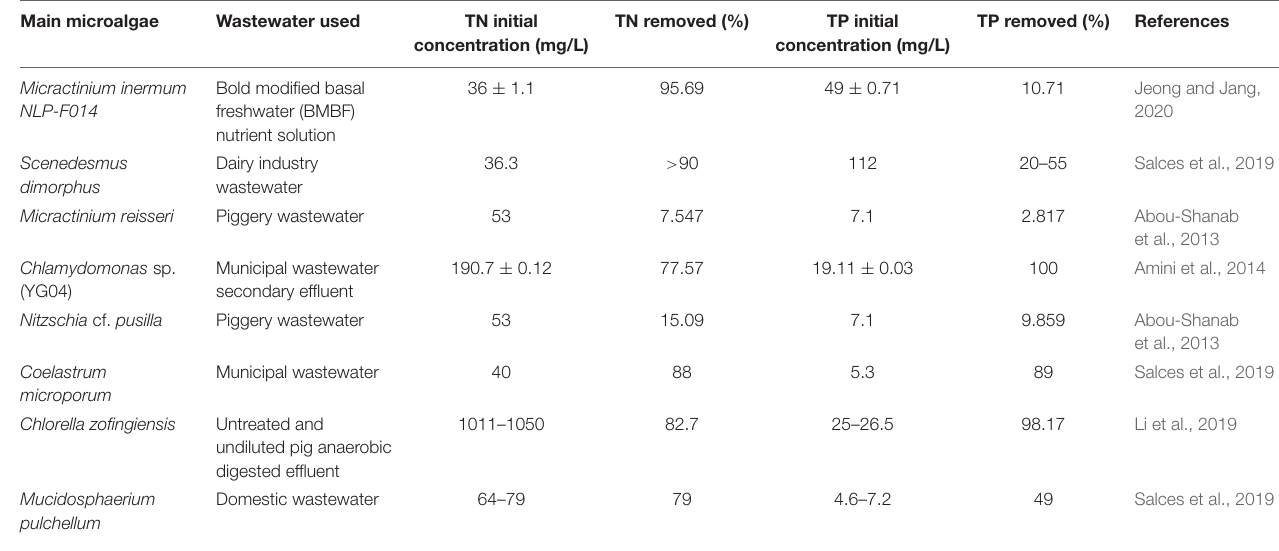
TABLE 1 | Showing effectiveness of different microalgal species at removing total nitrogen (TN) and total phosphorus (TP) from different